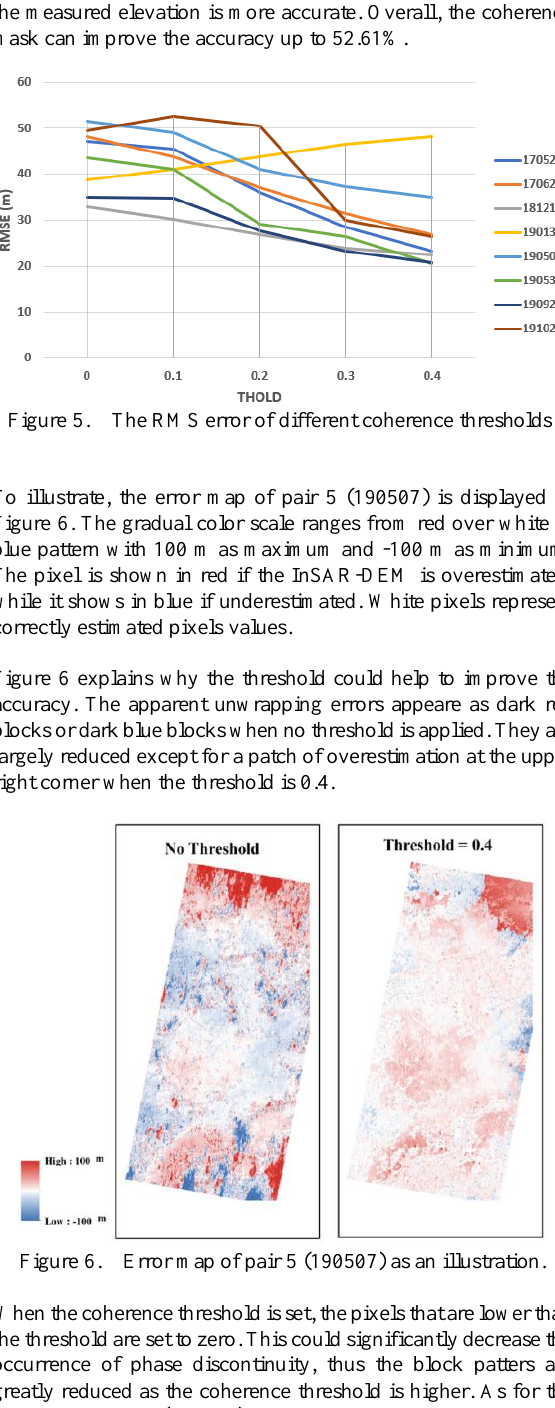
(1) three apparent groups of refractivity variation at around